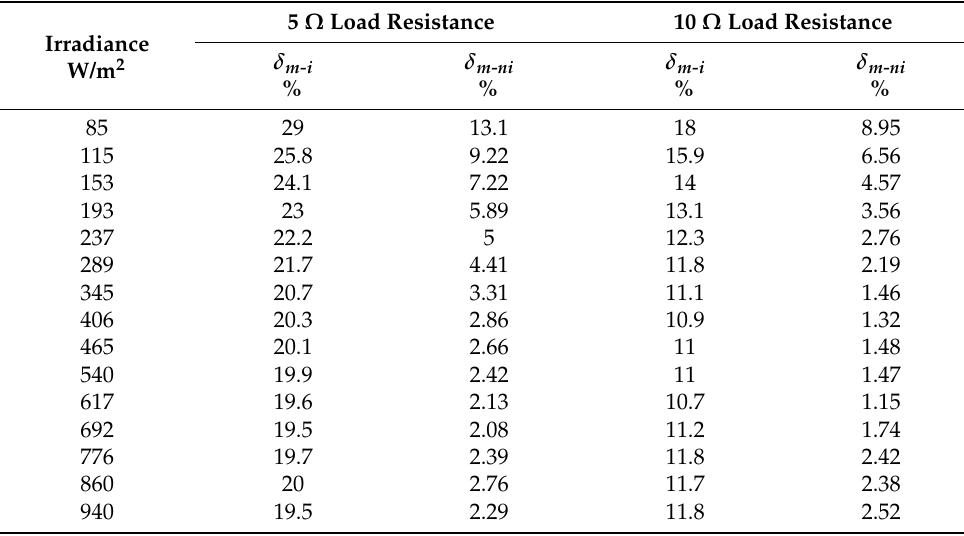
Table A4. Differences between measured and calculated values for a 5 W PV